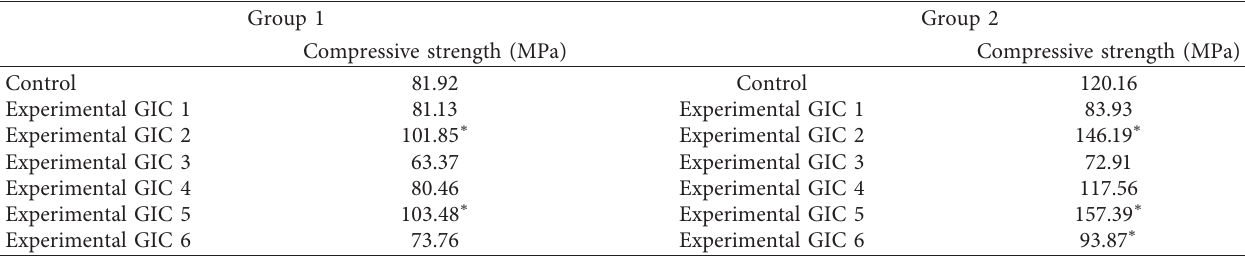
Table 2: Compressive strength of samples in Group 1 and 2.